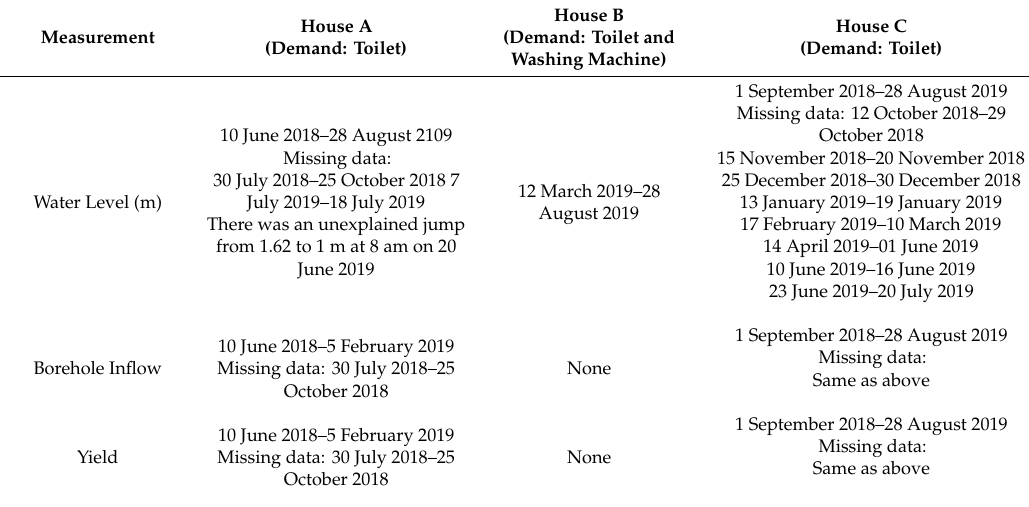
Table 1. Summary of data